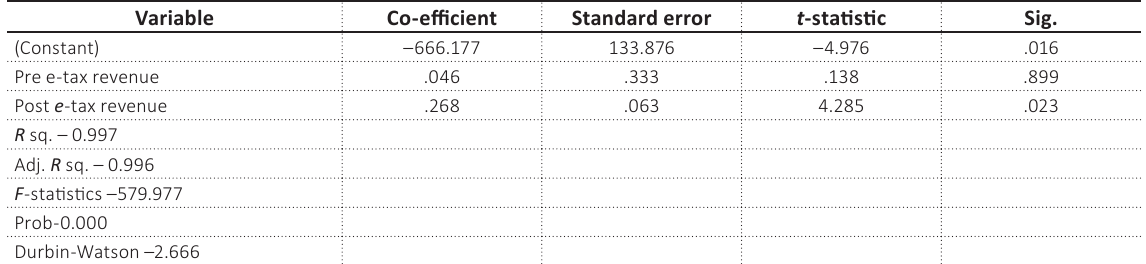
Table 2. Regression result of the variable